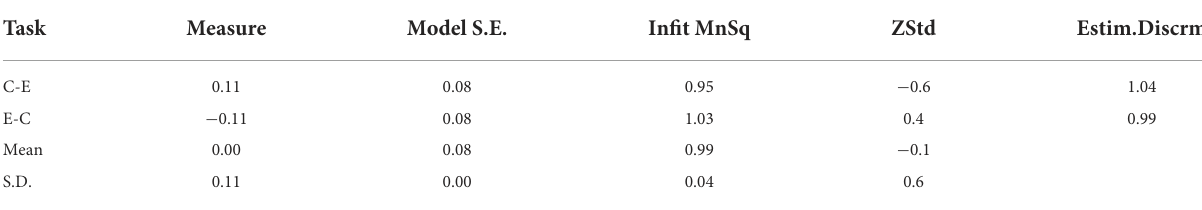
TABLE 8 Results of task level